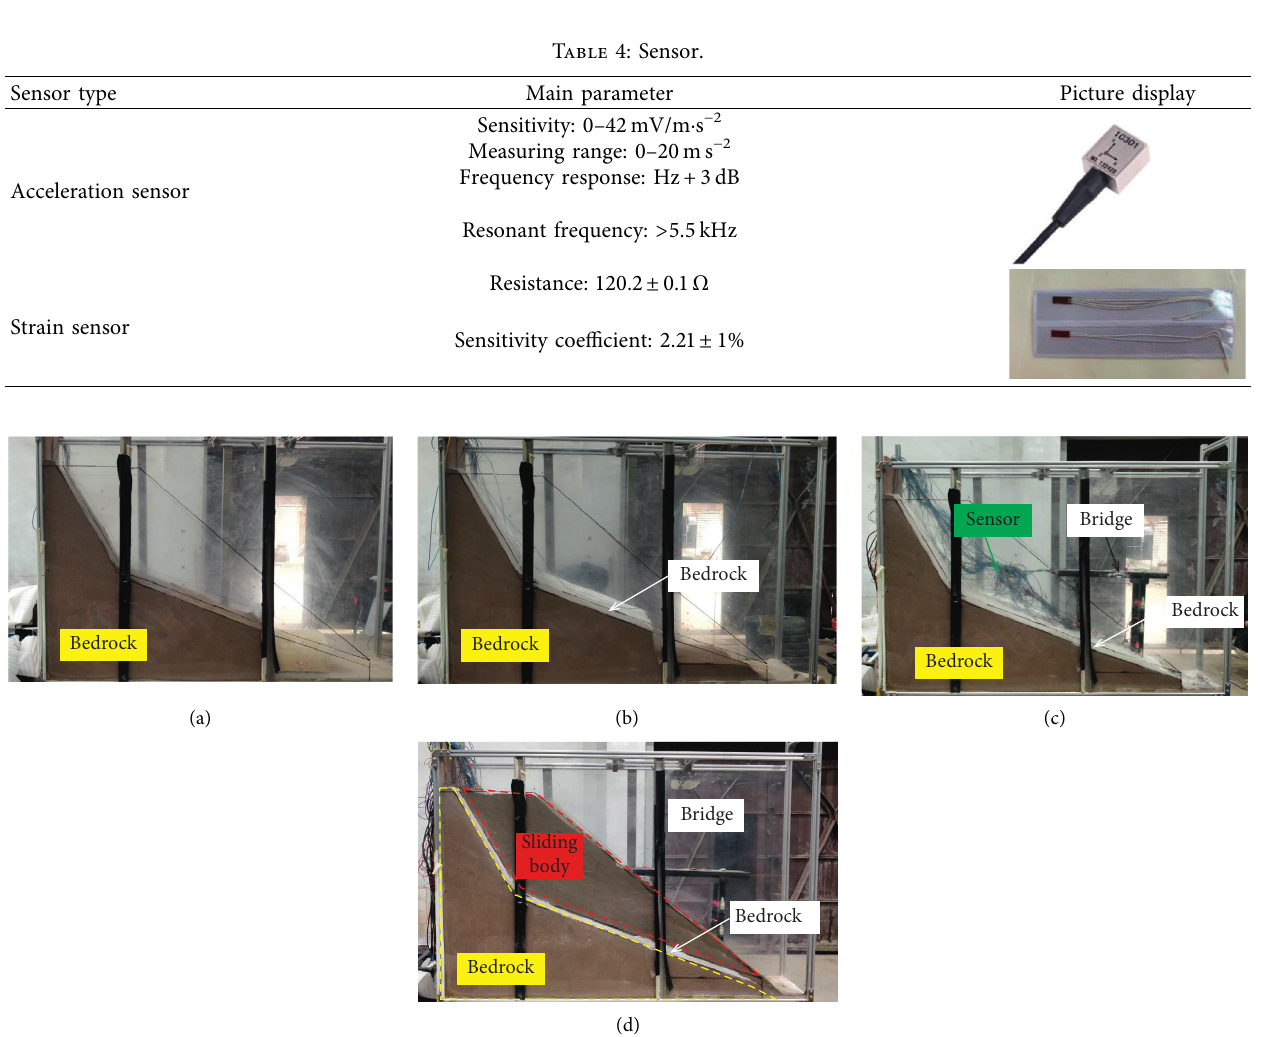
Figure 3: Filling process of model box. (a) Filling of bedrock. (b) Filling of slip zone. (c) Layout of model and sensor. (d) Model filling completed.